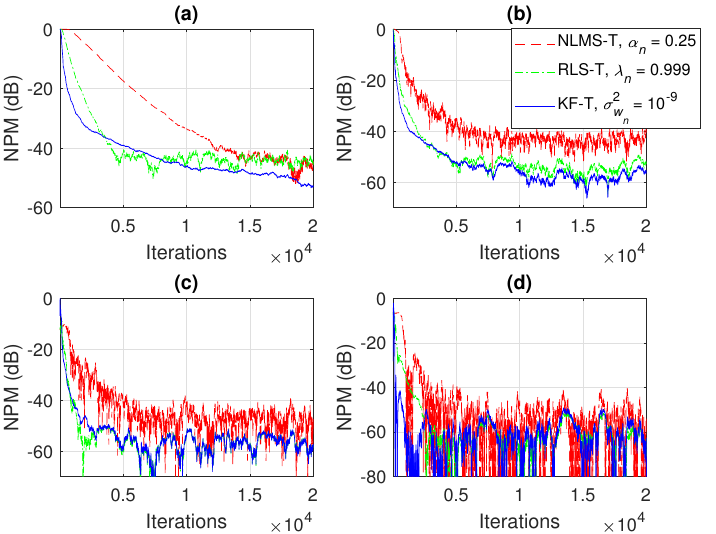
Figure 10. Normalized projection misalignment (NPM) of the NLMS-T algorithm using α n = 0.25, n = 1,2, . . . , N , the RLS-T algorithm using λ n = 0.999, n = 1,2, . . . , N , and the KF-T = 10 − 9 , n = 1,2, . . . , N , for the identification of the individual impulse responses, using σ 2 w n (cid:104) (cid:105) (cid:104) (cid:105) (cid:104) (cid:105) h n ( t ) , n = 1,2, . . . , n . ( a ) NPM h 1 ( t ) , (cid:98) h 1 ( t ) h 2 ( t ) , (cid:98) h 2 ( t ) h 3 ( t ) , (cid:98) h 3 ( t ) , ( b ) NPM , ( c ) NPM ,